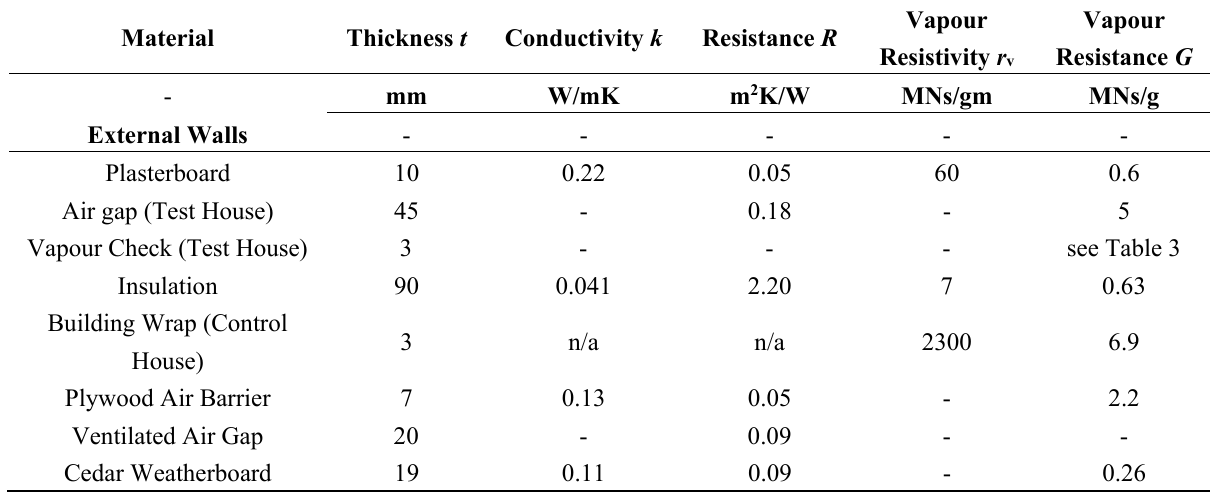
Table 2. Thermal and hygroscopic properties of